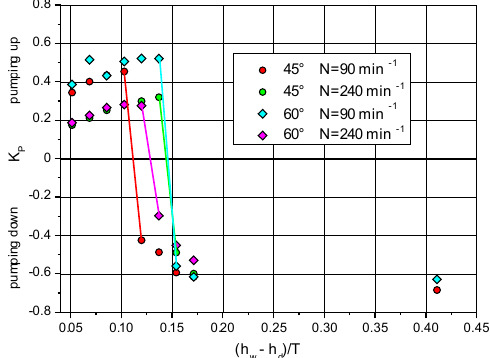
Figure 5. Pumping capacity depending on the height of the liquid in the tank. Lines (sections) connect the points between which the direction of the liquid flow through the impeller changes. After changing the pumping direction, no significant dif- ferences in the absolute values of the pumping numbers are observed. Moreover, when pumping upwards, in some cases the pumping capacity is even slightly reduced. This